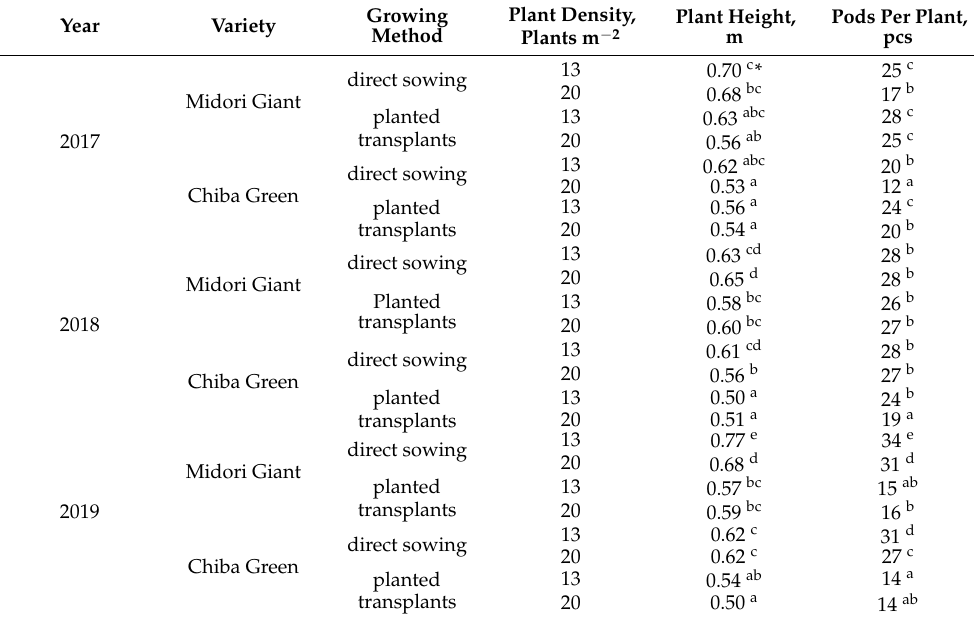
Table 5. Morphological and productivity parameters for vegetable soybean in the period from 2017 to 2019.